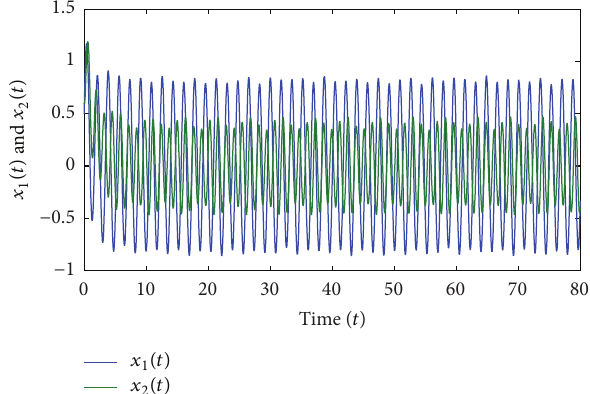
Figure 1: Almost periodicity of state variables 𝑥 1 (𝑡) and 𝑥 2 (𝑡) .